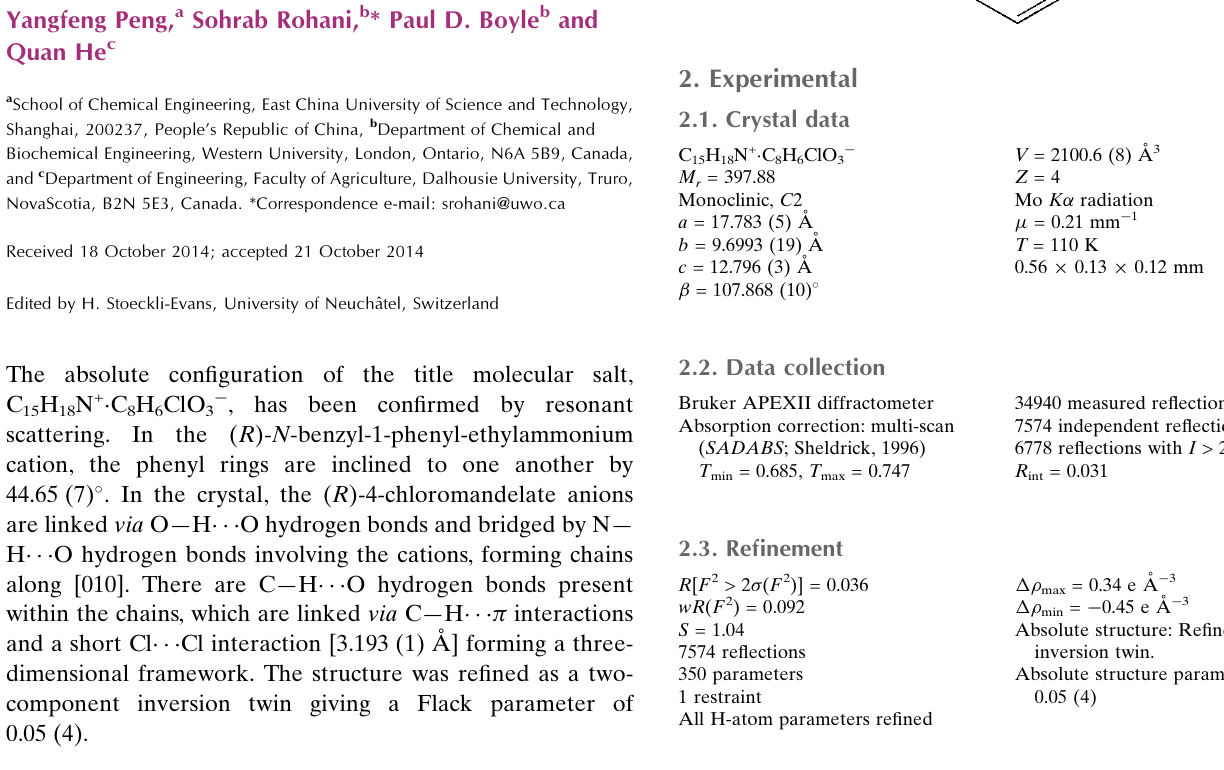
Bruker APEXII diffractometer Absorption correction: multi-scan